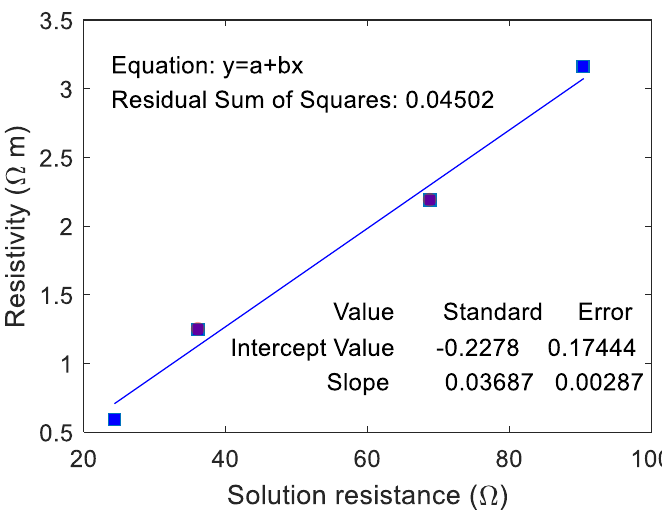
Figure 12. Correlation between resistivity and solution resistance of mortar specimen.